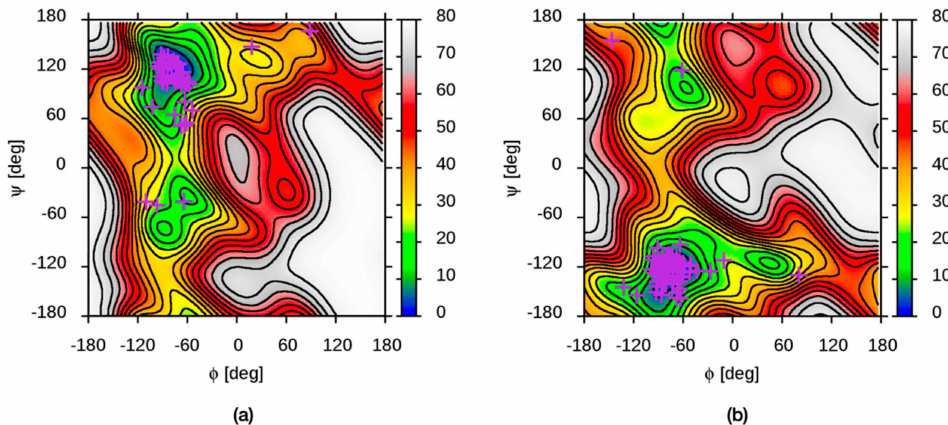
Figure 4. Computed hyaluronan disaccharide conformational free energies compared with all available PDB hyaluronan structural data for ( a ) ( φ 14 , ψ 14 ) and ( b ) ( φ 13 , ψ 13 ) glycosidic linkage dihedrals. Free energy data, in kJ/mol and shown as contours, are adapted with permission from Figure S1 from reference [123], copyright 2021 American Chemical Society, and PDB data, shown as +’s, are from Table 2 in the present work. Free energies were computed from all-atom explicit-solvent molecular dynamics simulations of ( a ) GlcNAc β 1-4GlcA and ( b ) GlcA β 1-3GlcNAc disaccharides using the CHARMM force